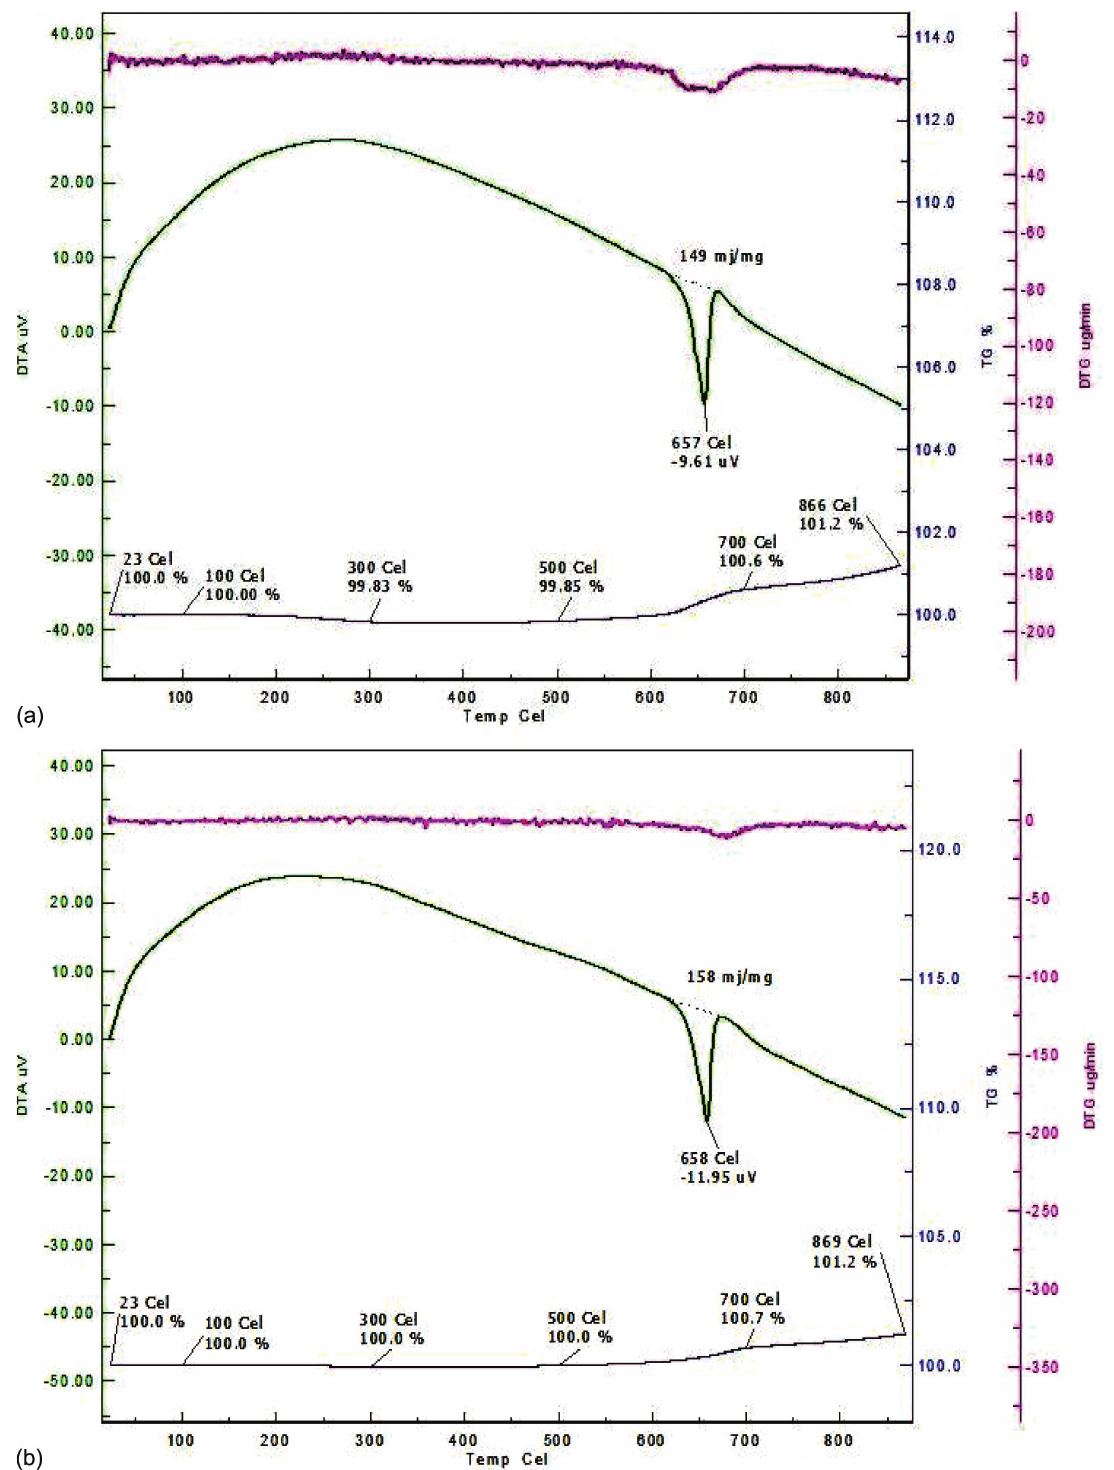
Fig. 2: (a) DTA and TGA of Al. (b) TGA and DTA of Al composite with 10 wt% of SiC with 1 wt% of